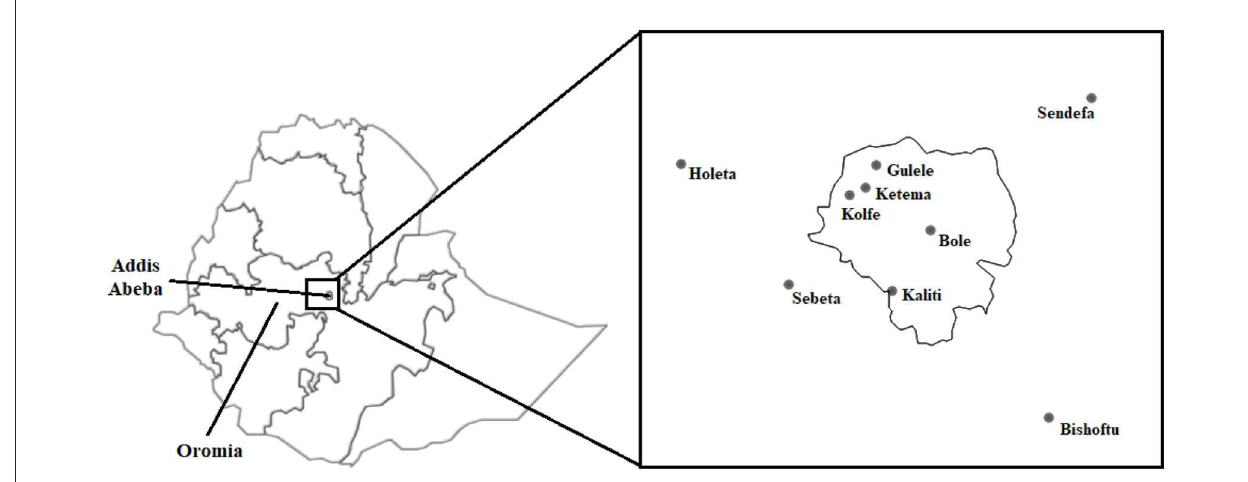
FIGURE1 Map of the study area (Authors’